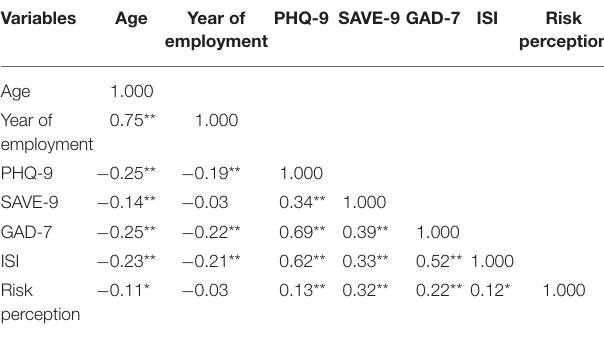
TABLE 3 | Spearman’s correlation coefficients of each